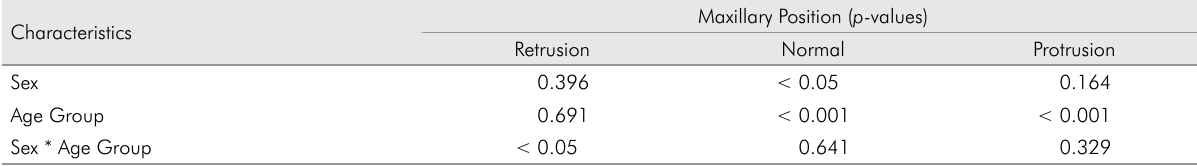
Table 4. Effects of evaluators’ characteristics on evaluations of the